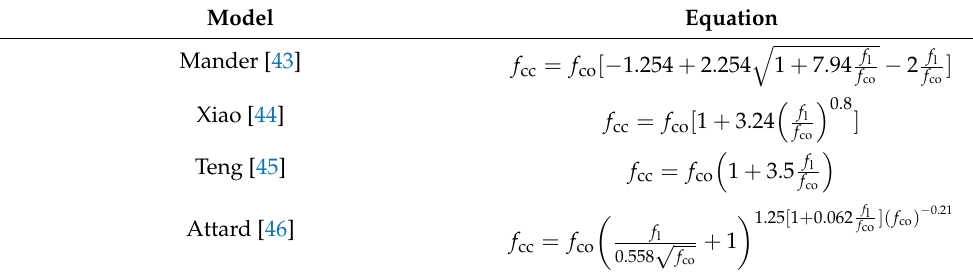
Table 4. Proposals for calculating the strength of confined concrete columns.